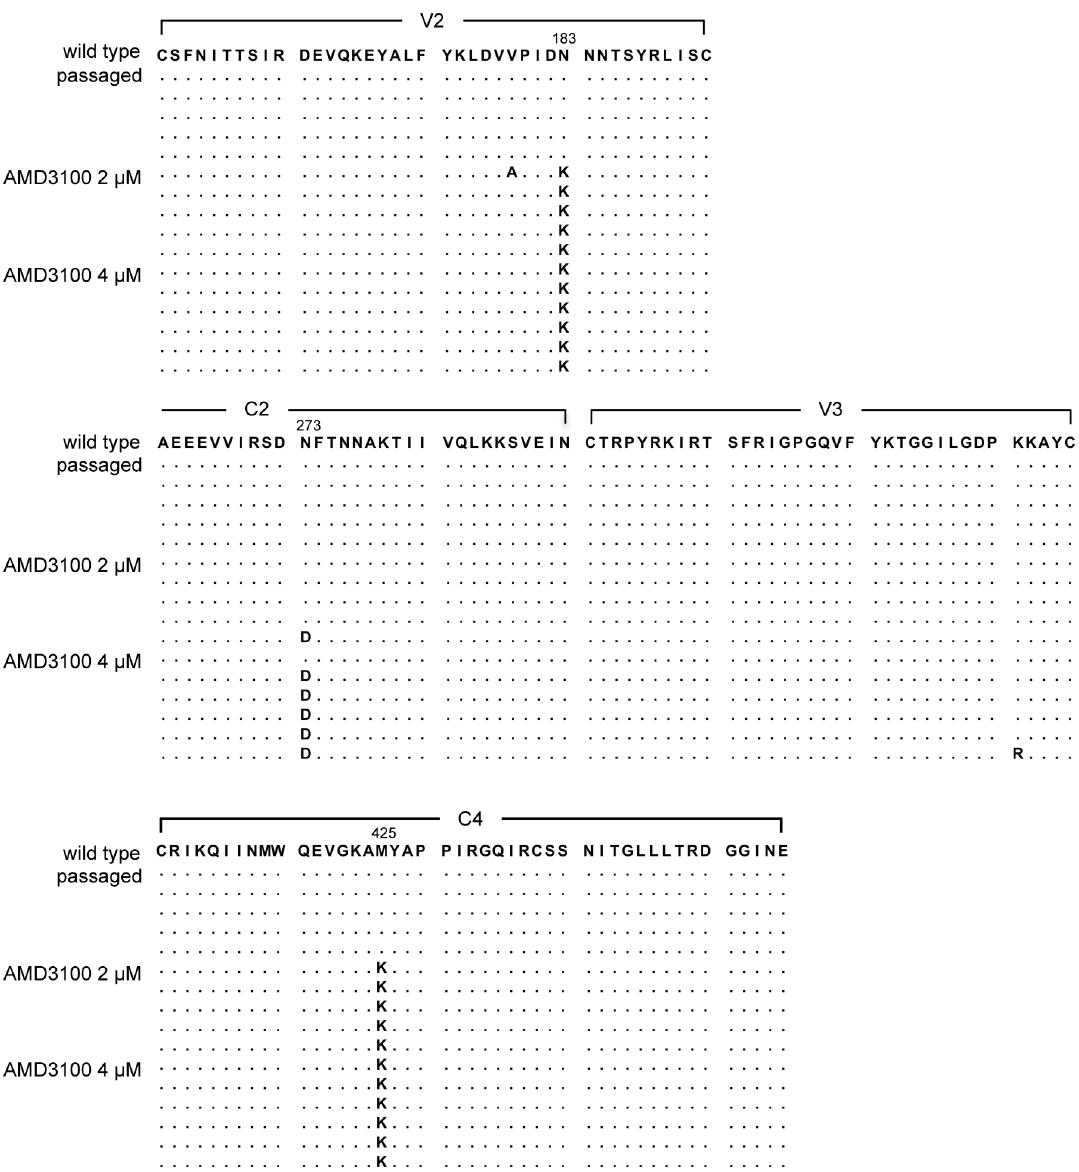
Figure 3. Amino acid sequences of the AMD3100-escape variant. Amplified products from infected SupT1/CCR5 cells in the absence or presence of AMD3100 were cloned, and five to six clones from each sample were sequenced. The amino acid sequences of V2, C2, and C4 of the wild- type HIV-1 JR-FLan/KI812.7 are shown in the top line. In each set of clones, the deduced amino acid sequence was aligned by the single amino acid code. Identity with this sequence at individual amino acid positions is indicated by